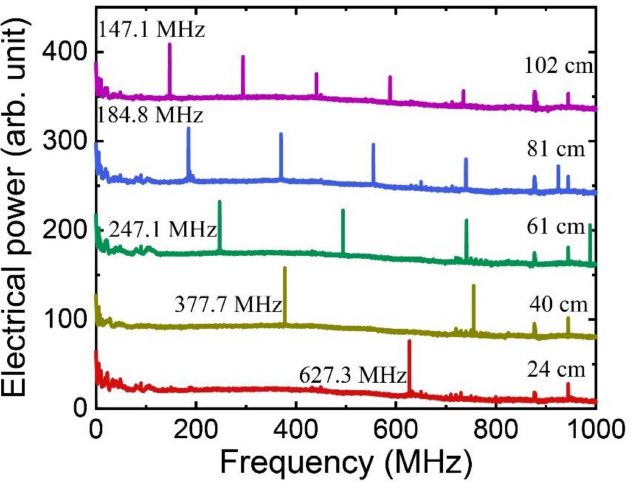
Figure 5. Electrical spectra of P1 oscillations for various single-trip feedback lengths. The pump current is 290